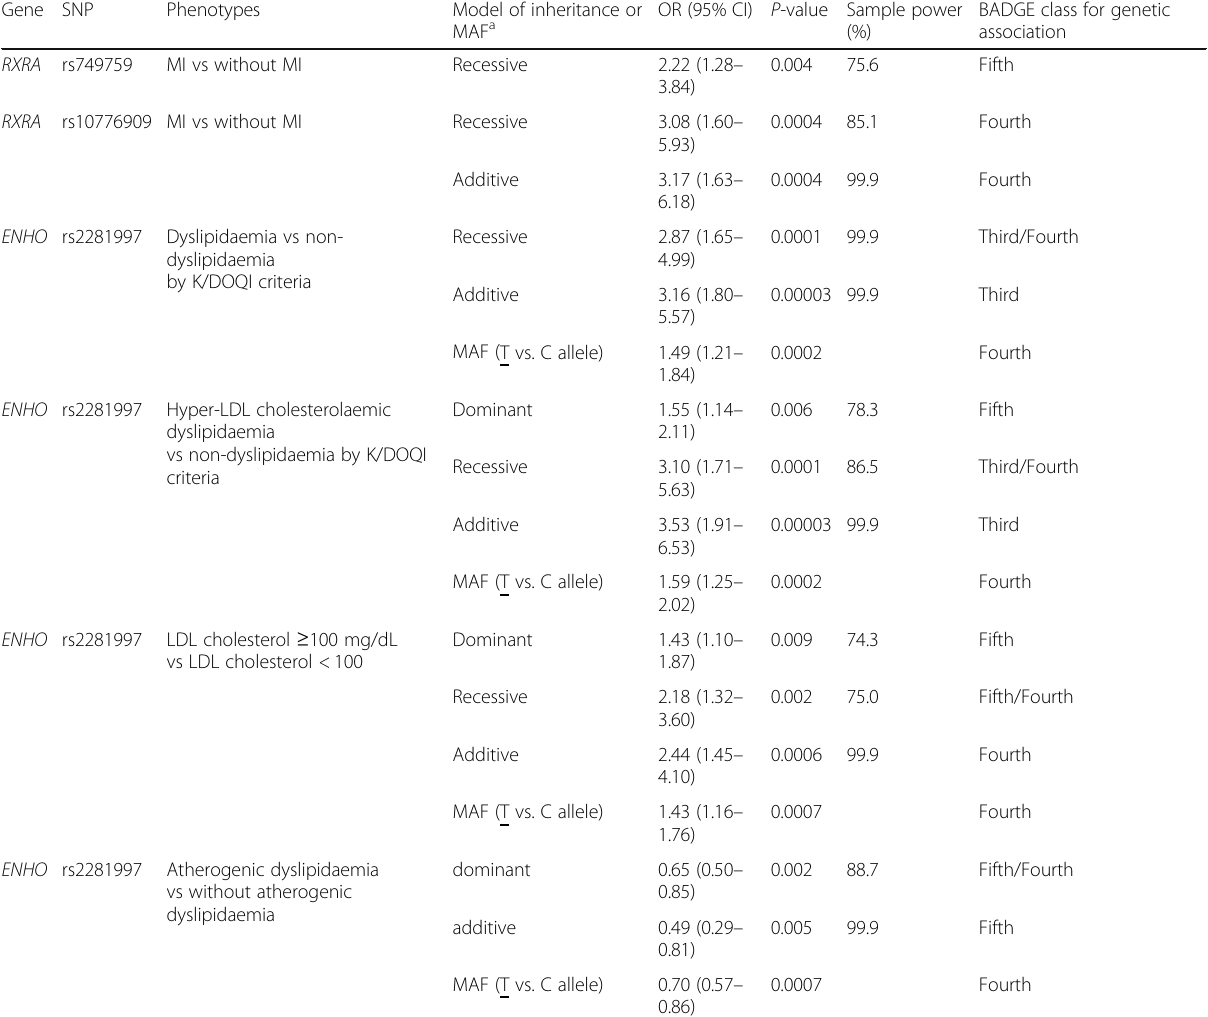
Table 2 Significant associations between the tested polymorphisms and analysed phenotypes Gene SNP